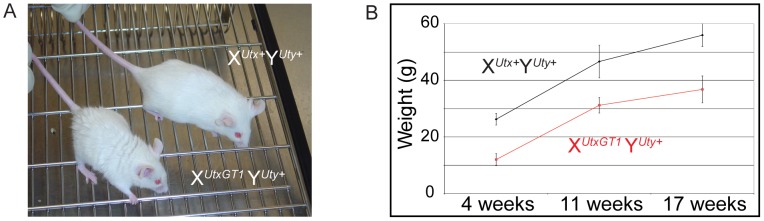
Hemizygous male Utx mutant mice are runted.(A) Hemizygous male Utx mutant mice are runted in size. Wild type male XUtx
+ Y+ mice are displayed next to hemizygous XUtxGT1 Y+ mice. (B) The hemizygous mice exhibit a smaller size throughout adulthood.